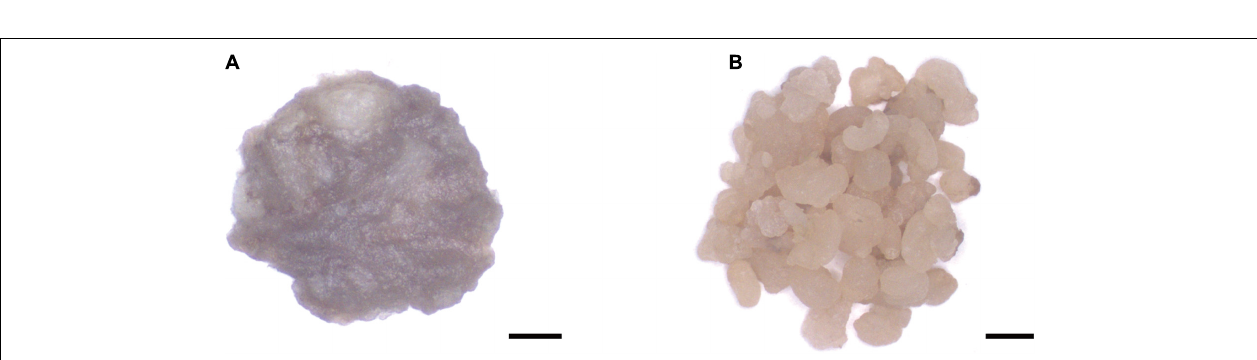
FIGURE 1 | Construction and transfer verification of TwSQS , TwSE , and TwOSC overexpression vectors. (A) TwSQS , TwSE , and TwOSC overexpression fragments. TwSQS overexpression fragment of 1,241 bp, TwSE overexpression fragment of 1,584 bp, and TwOSC overexpression fragment of 2,298 bp. (B) Verification of successful transfer of overexpression vectors in Tripterygium wilfordii CMCs and DDCs. Agarose gel electrophoresis showed the hygromycin fragment (1,787 bp). (C) Schematic diagram of overexpression vectors. OE, overexpression; Hyg, hygromycin.